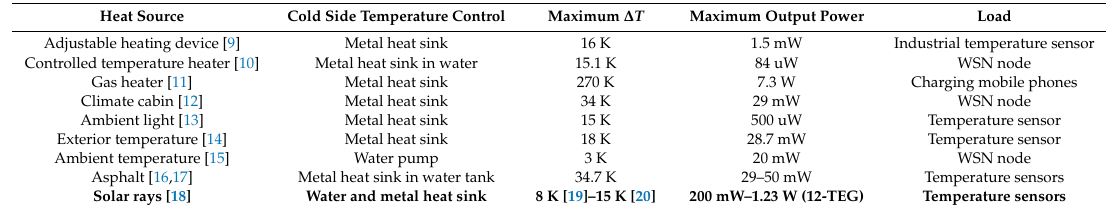
Table 1. Comparison of TEH